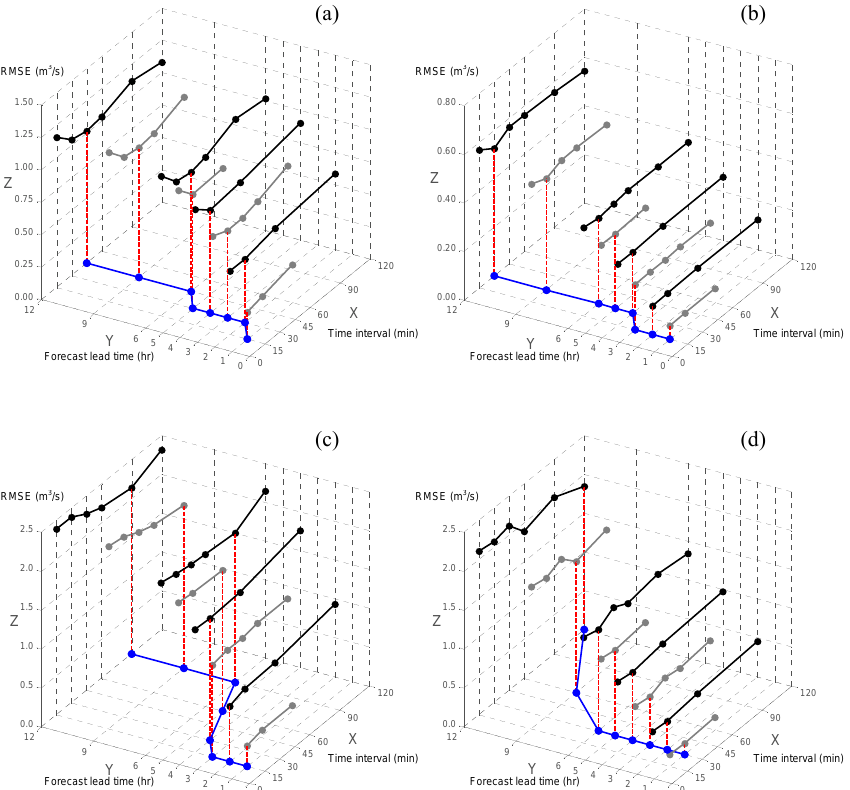
Fig. 7. Forecasting results in three-dimensional coordinates for the four catchments, of Bellever, Halsewater, Brue and Bishop_Hull, respectively in subfigures (a), (b), (c) and (d).